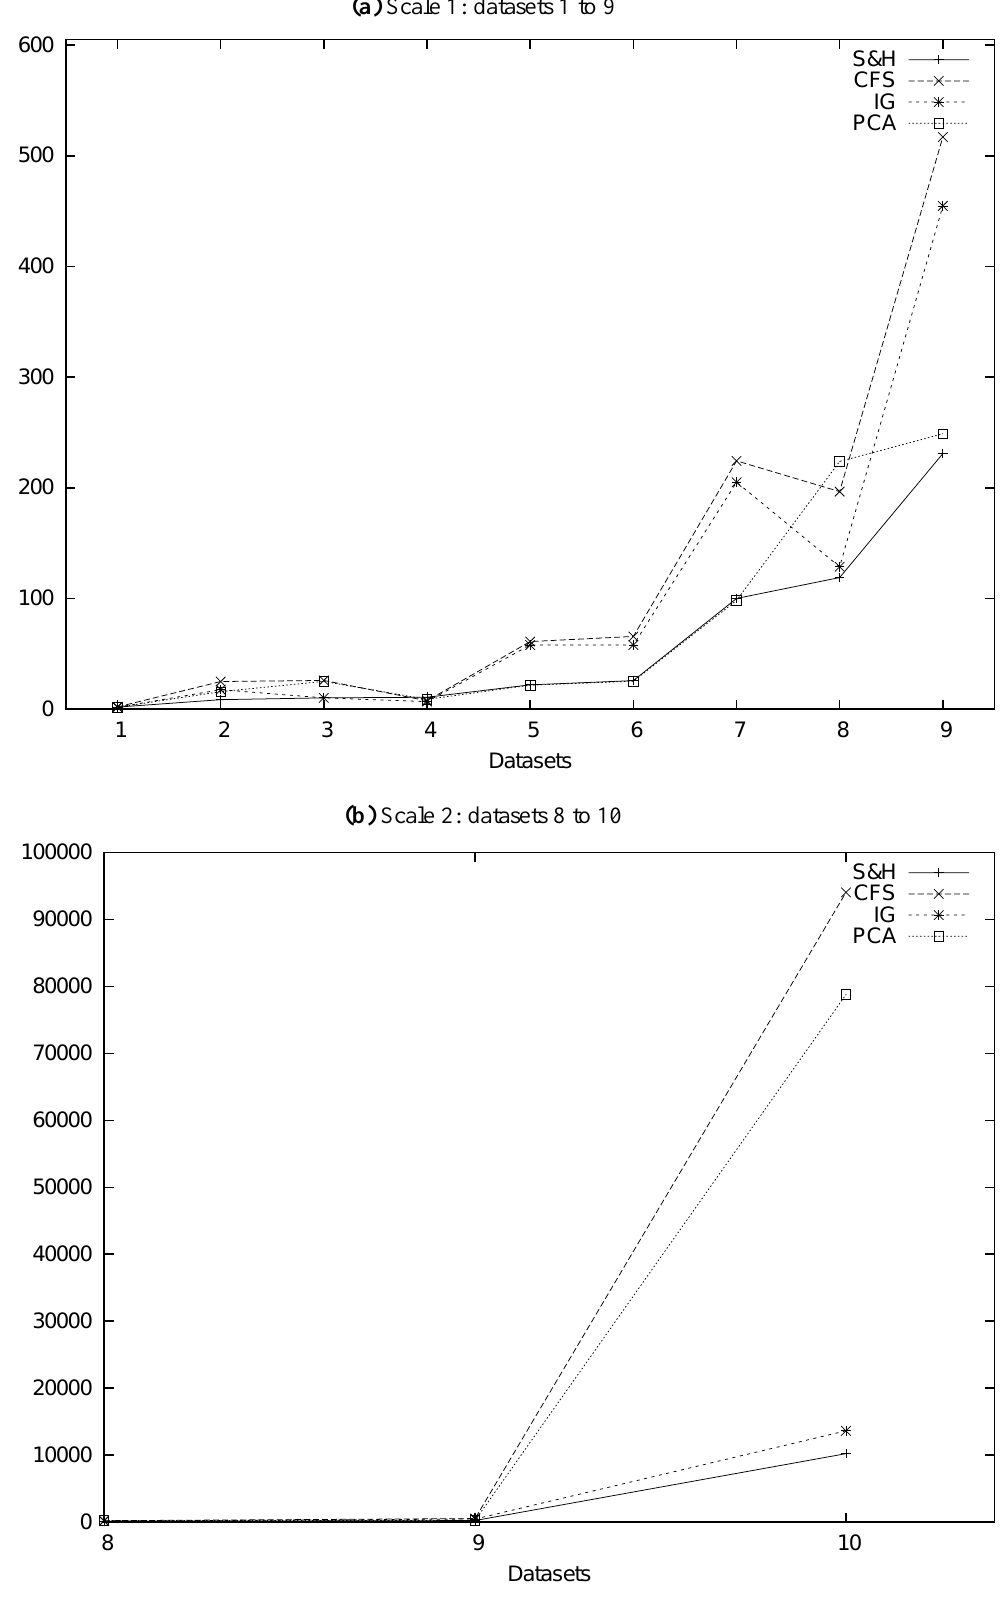
Figure 18. Feature reduction time comparisons. (a) Scale 1: datasets 1 to 9